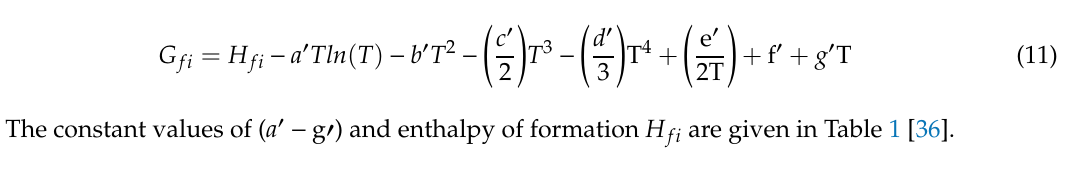
Table 1. The values of H fi (kJ / mol) and the coe ffi cients of Equation (11) G fi (kJ / mol).